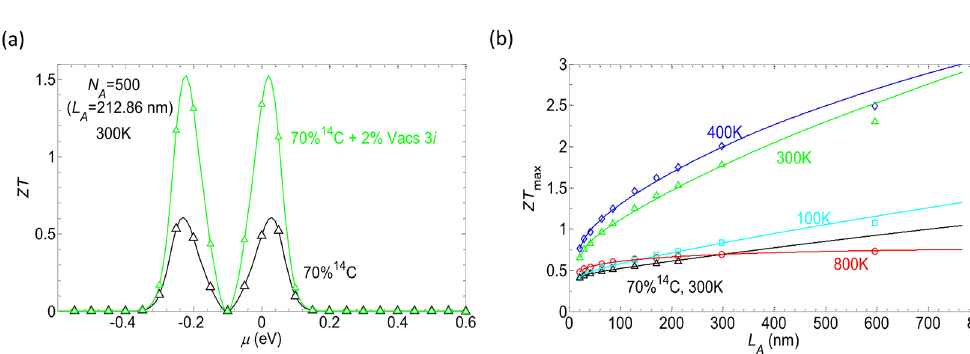
Figure 8. ( a ) Figure of merit ZT as a function of chemical energy demonstrated for an isotope doped device of length 212.86 nm with and without additional vacancies 3 i . ( b ) ZT max as a function of the device length, except for the black lines corresponding to isotopes only, other curves refer to of the combined effects of 70% isotope doping plus 2% 3 i vacancies, the symbols are numerical data and the solid lines are the fitting curves. Data provided for M = 5